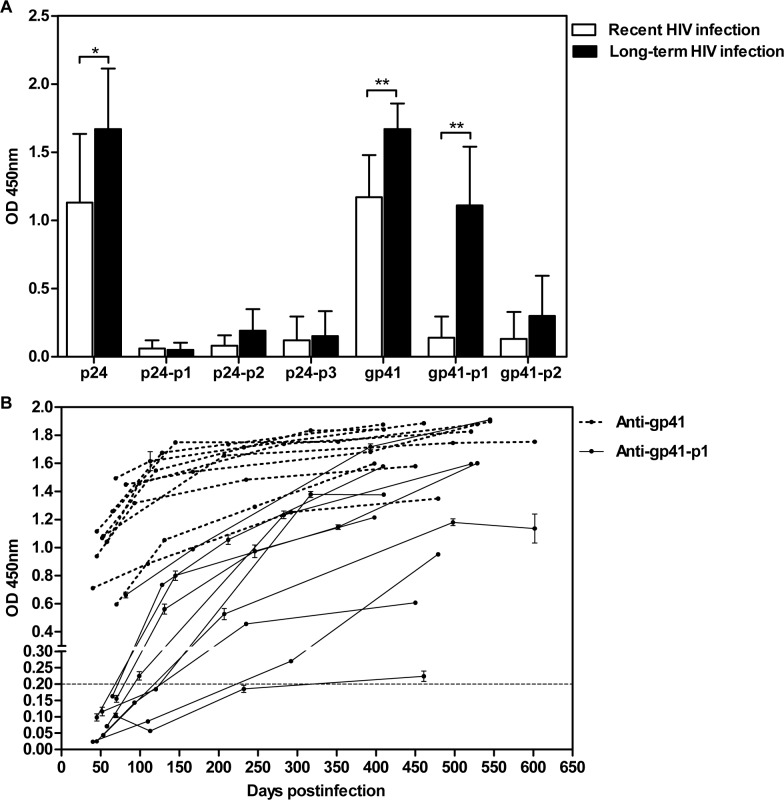
Detection of antibodies against p24 or gp41 recombinant proteins and peptides in the longitudinal samples.The antibody titers are plotted as optical density (OD) on the y-axis. (A) Testing of antibodies against recombinant p24, gp41 and the peptides p24-p1, p24-p2, p24-p3, gp41-p1, gp41-p2 in 37 well-characterized samples from recently (white) or long-term (black) HIV-1-infected subjects. * P< 0.05, ** P< 0.01. (B) Antibody titers against recombinant gp41 (dotted line) and peptide gp41-p1 (solid line) in the 40 longitudinal sera from 10 HIV-1 infected individuals at different time points. The “recent/long-standing” infection cutoff value is shown by the horizontal dashed line.